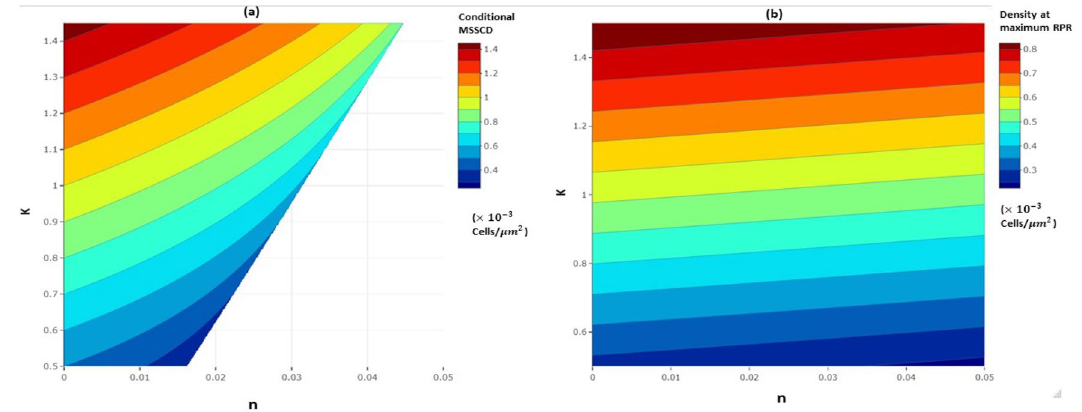
Figure 4. The distribution of conditional MSSCD and cell density at maximum RPR in n-K parametric plane.